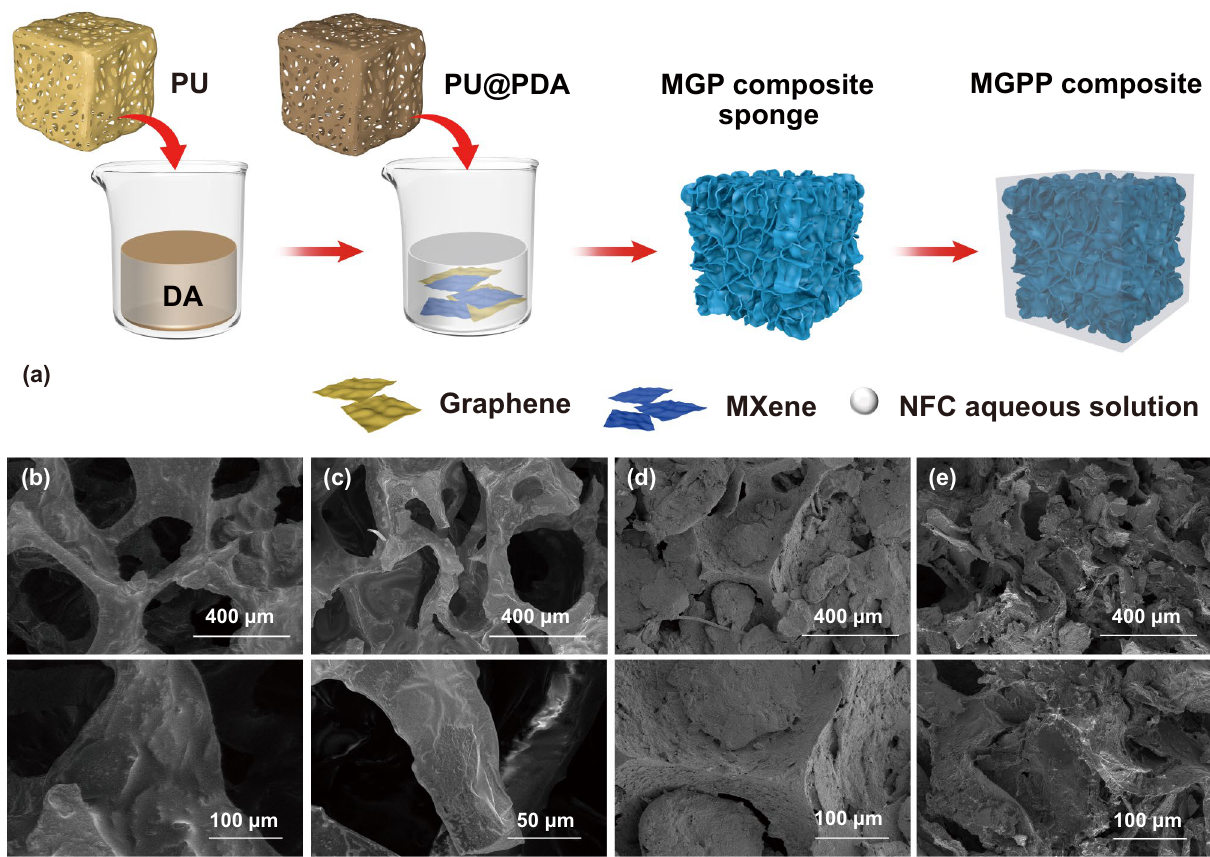
Fig. 1 a Process for fabricating MGPP composites. Surface SEM images of b PU, c PU@PDA, d MGP100 composite sponges, and e MGP100-3 composite sponges and their corresponding magnification